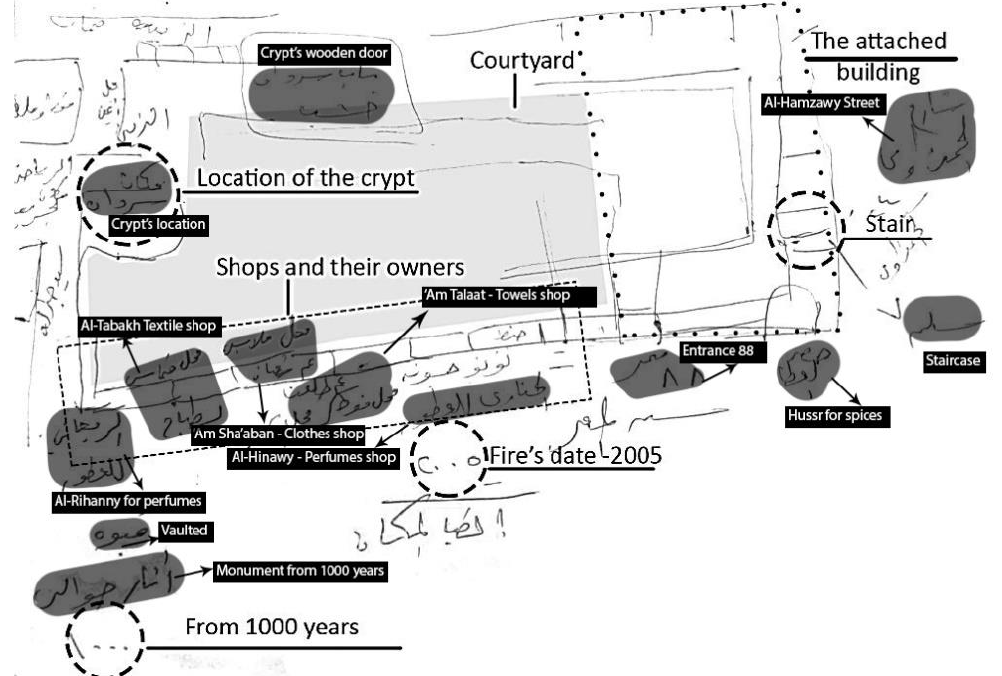
Figure 10. Interviewee's drawing of Wikāliẗ ạl - ’Anbariyin 's plan. It shows the names of shop owners, the crypt's location, the fire's date (2005), the building's history (1000 years), the courtyard, and other architectural elements.